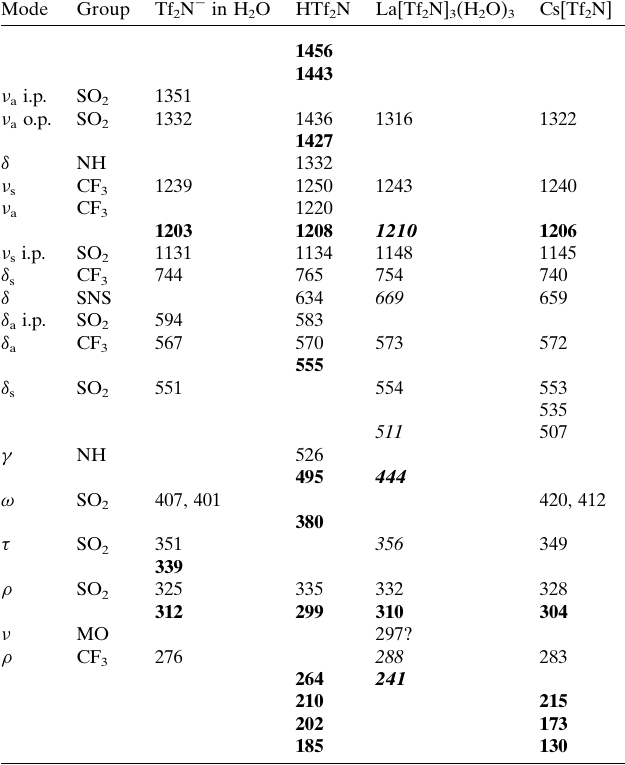
Table 1 Comparison of Raman modes in Tf 2 N compounds. Comparison of observed Raman shifts in cm (cid:3) 1 from Tf 2 N-containing compounds. Band wavenumbers given in bold are unassigned and in italicized are from reanalysis of reported spectra for La[Tf 2 N] 3 (H 2 O) 3 . Major band assignments are given with (cid:3) (stretching), (cid:4) (bending), ! (wagging), (cid:5) (twisting) and (cid:6) (rocking) and planar designations are i.p. for in plane and o.p. for out of plane.